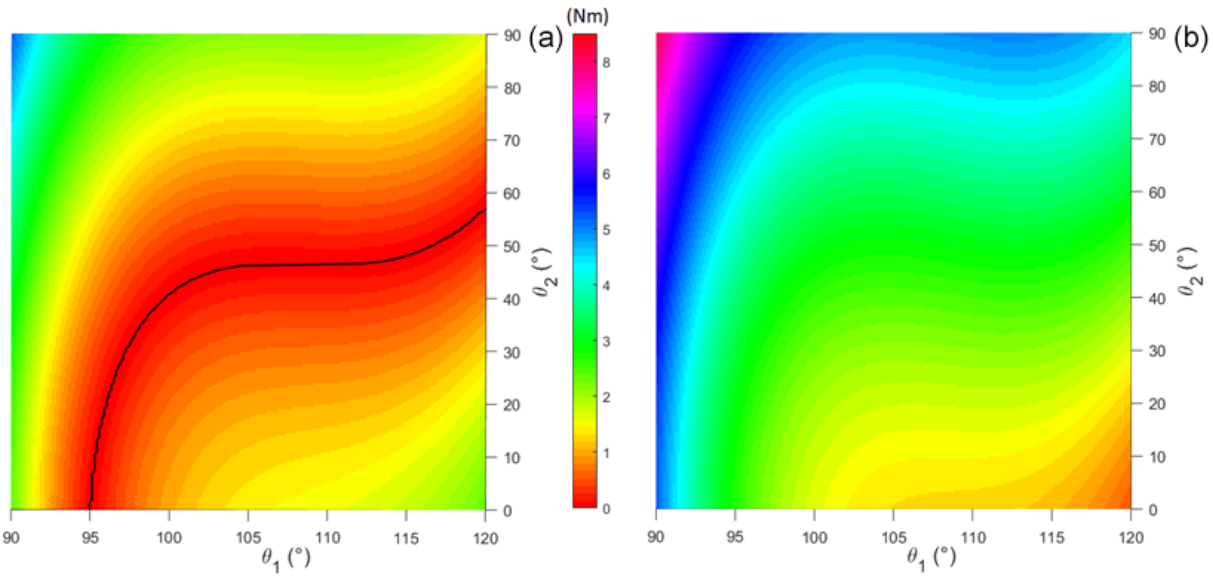
Figure 10. Surface of the absolute difference of the torque due to gravity, with no load, and the torque generated by the DMSP-10-100N PAM, projected on plane π : (cid:49) Torque = 0, by employing the shoulder pad at pressures of 5 (a) and 6bar (b)